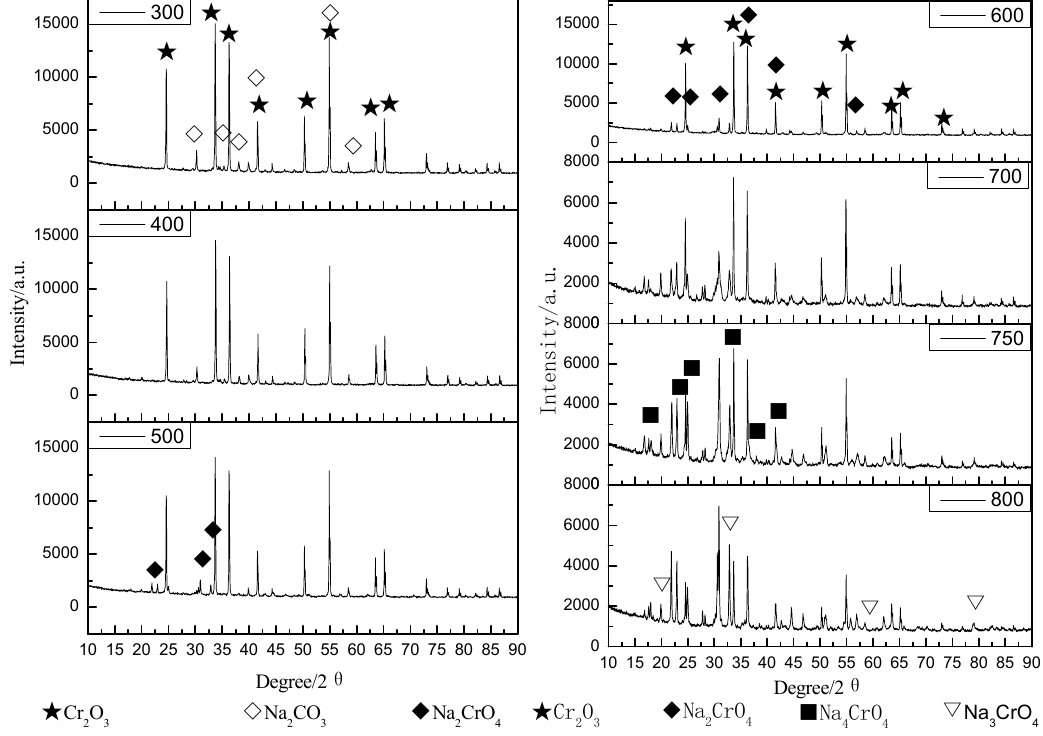
Figure 4. The XRD pattern of a sample of mixed Na 2 CO 3 and Cr 2 O 3 in a 1:1 ratio, at 300–800 °C for 1 h.